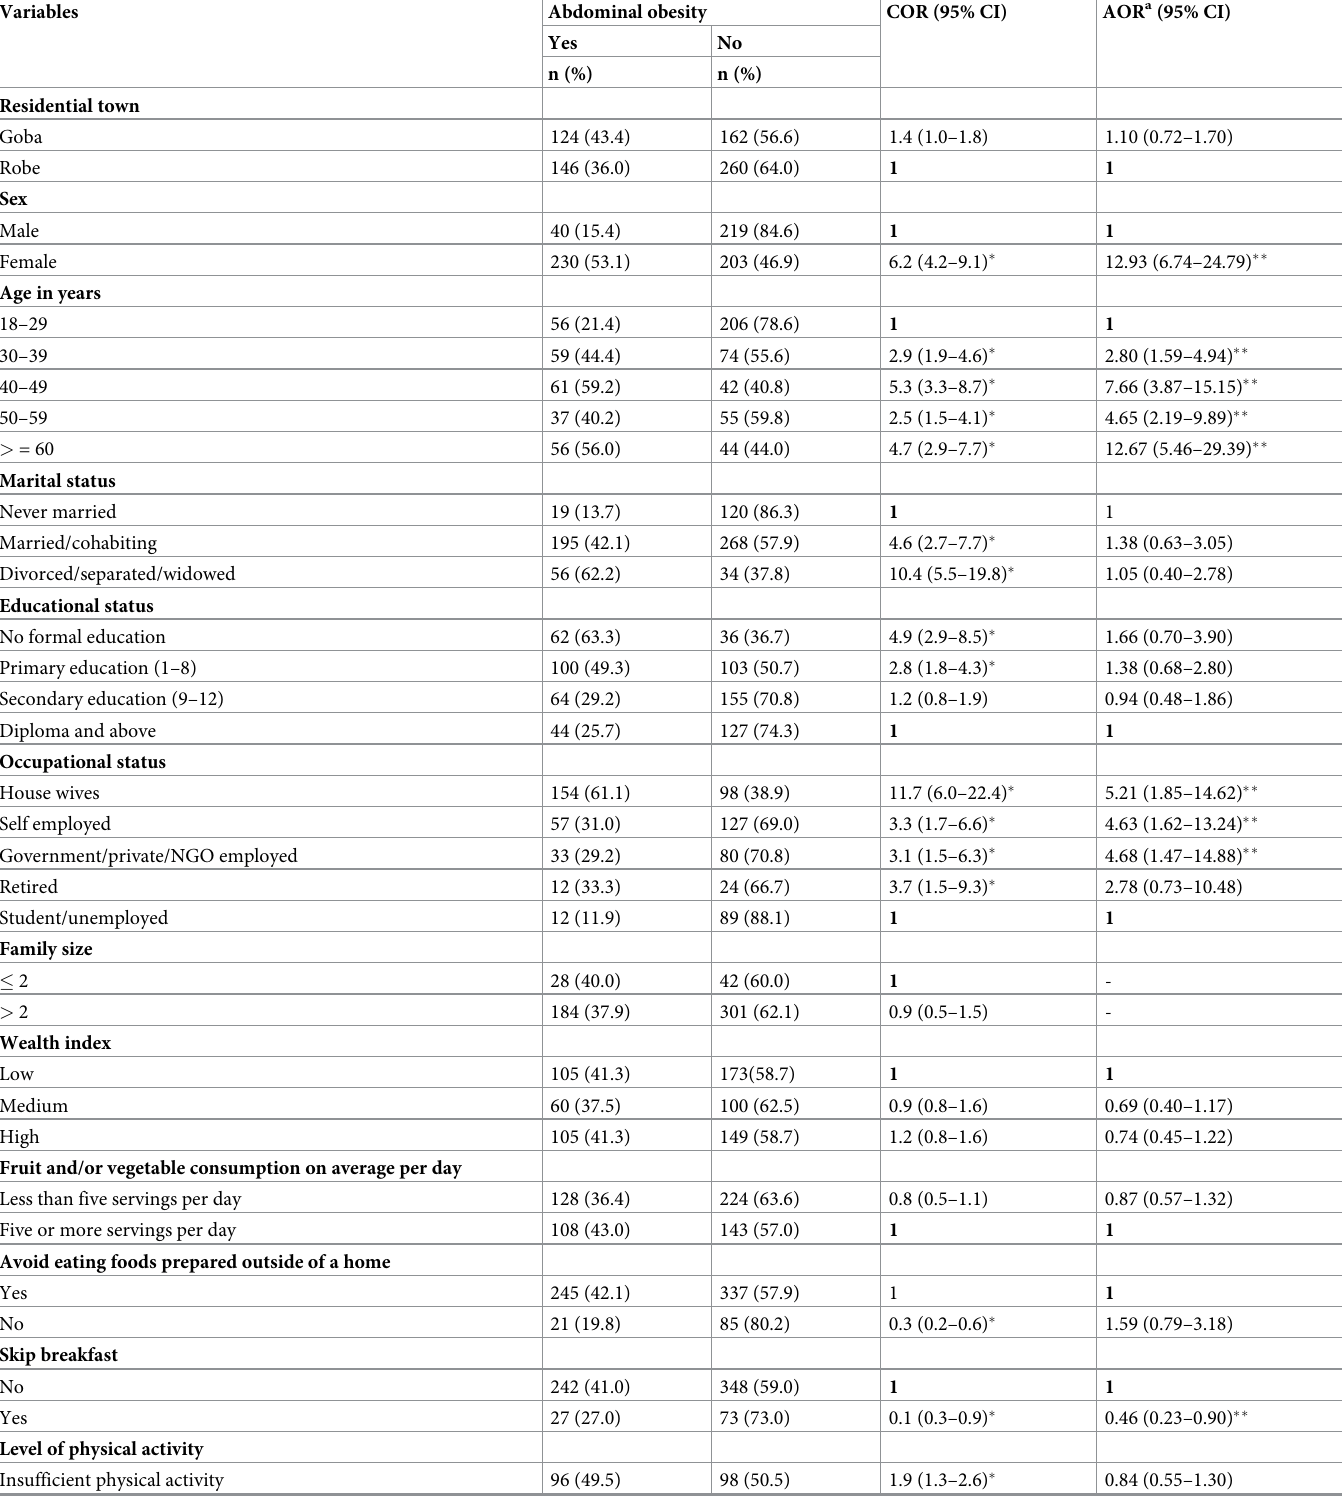
Table 5. Factors associated with central obesity among adult men in administrative towns of Bale zone, Southeast Ethiopia,